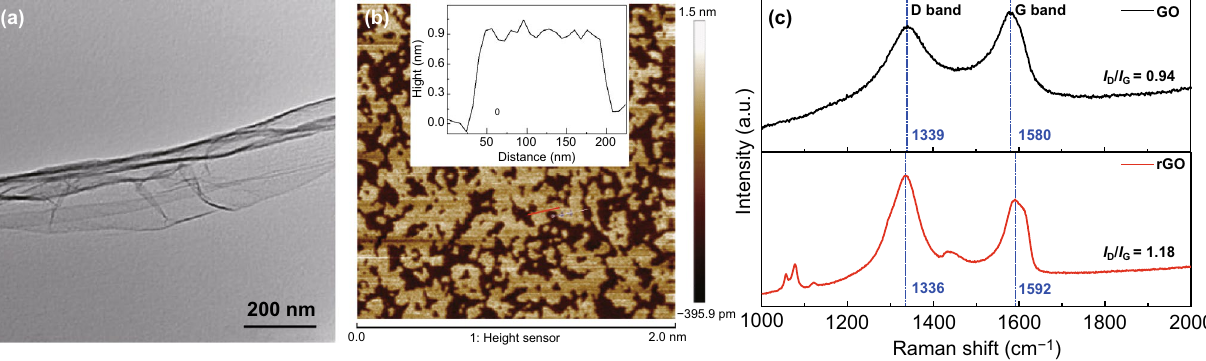
Fig. 2 a TEM and b AFM images of the GO flakes with the thickness distribution shown in the inset. c Raman spectra of GO and rGO